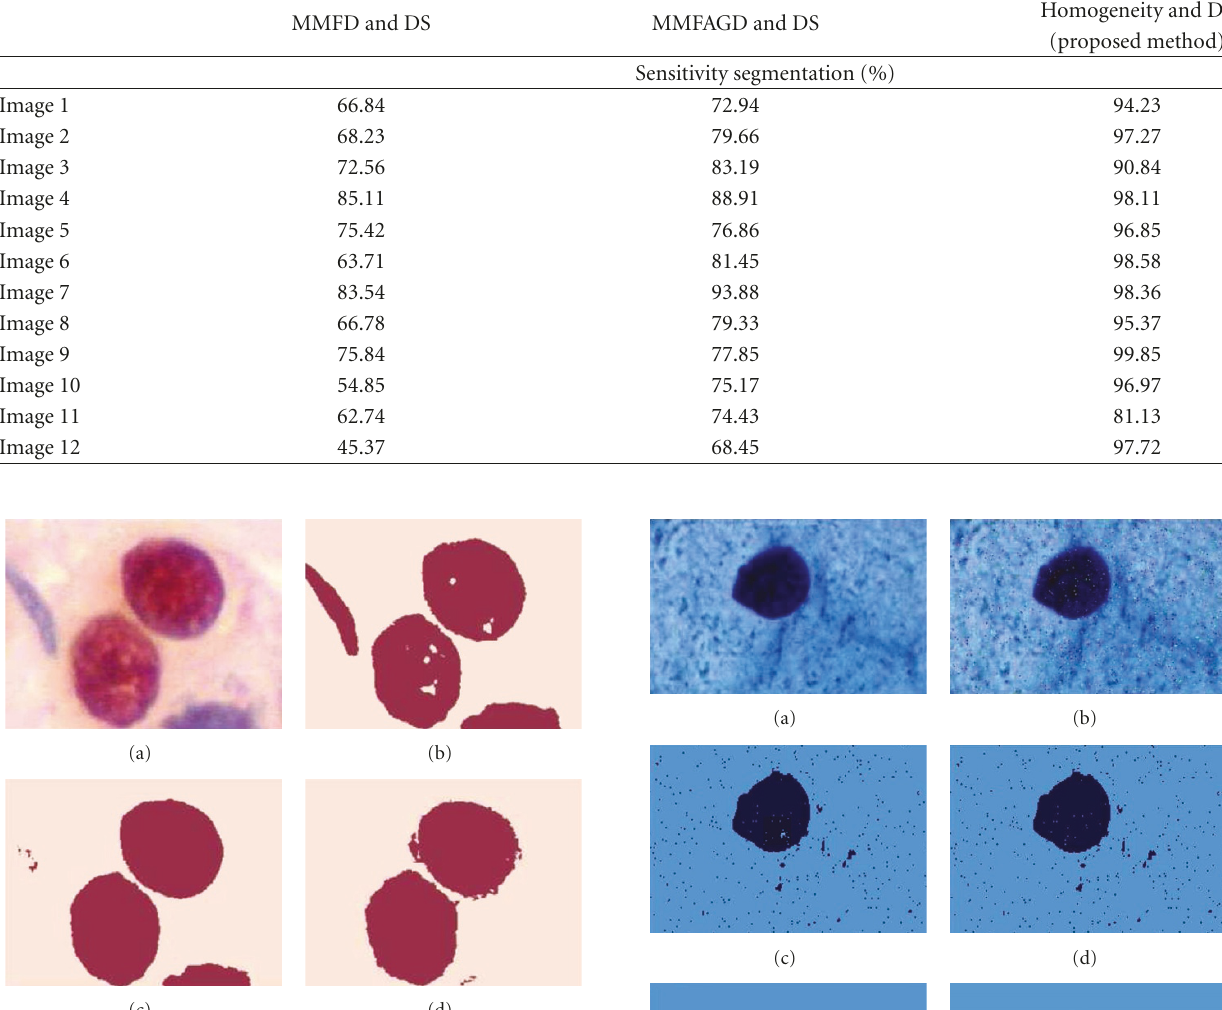
Homogeneity and DS